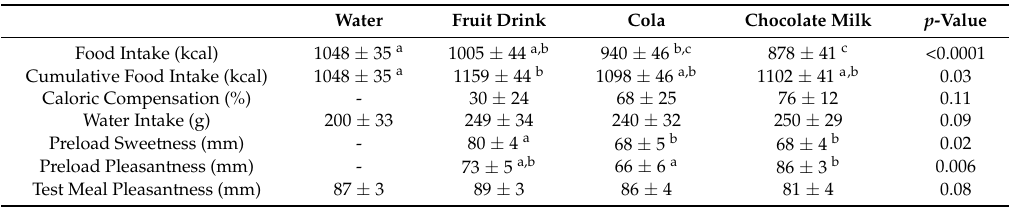
Table 2. The effect of preload beverages on food and water intake at 60 min and on the sweetness and pleasantness of the beverages and pizza 1